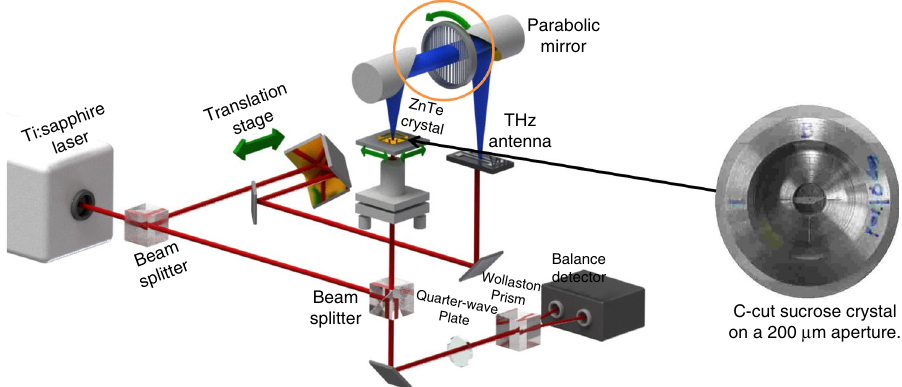
Fig. 2 Schematic of PV-ATM optical system. Sample rotation and X-Y imaging at each rotation is eliminated by THz polarization rotation